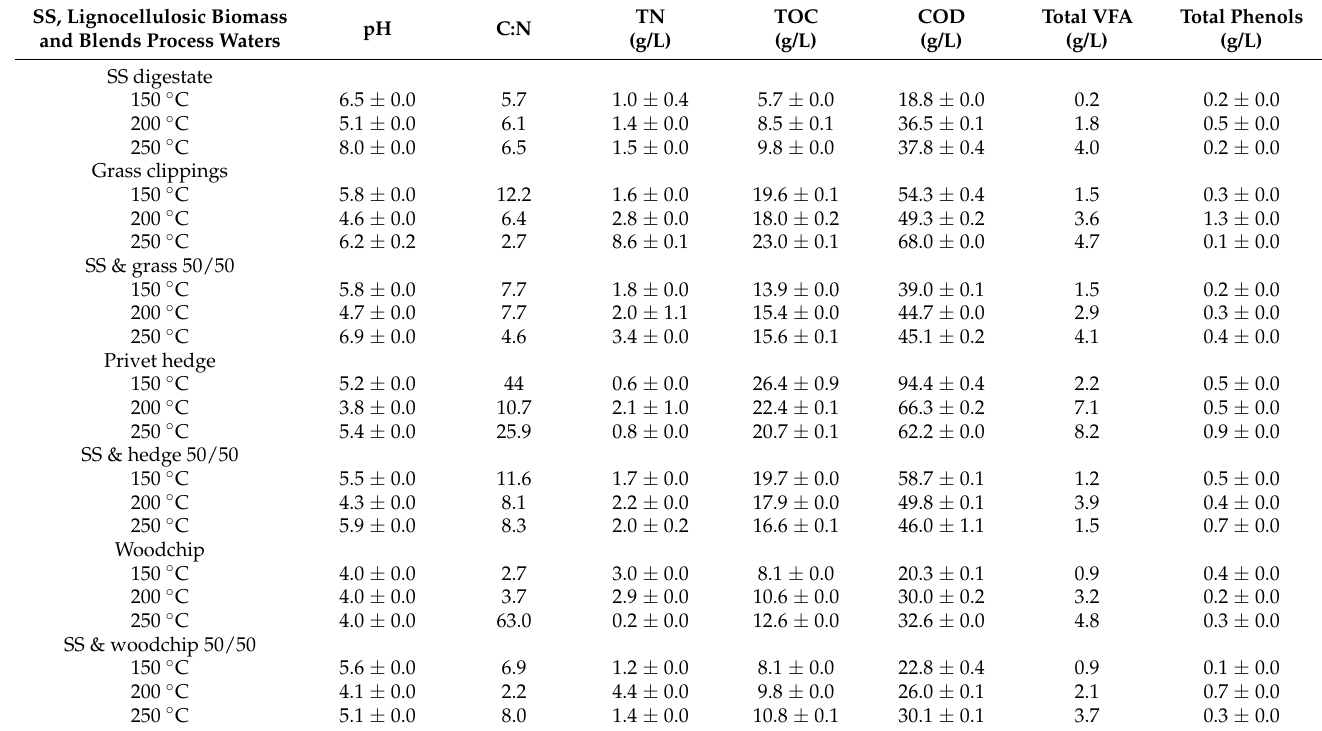
Table 7. Process water